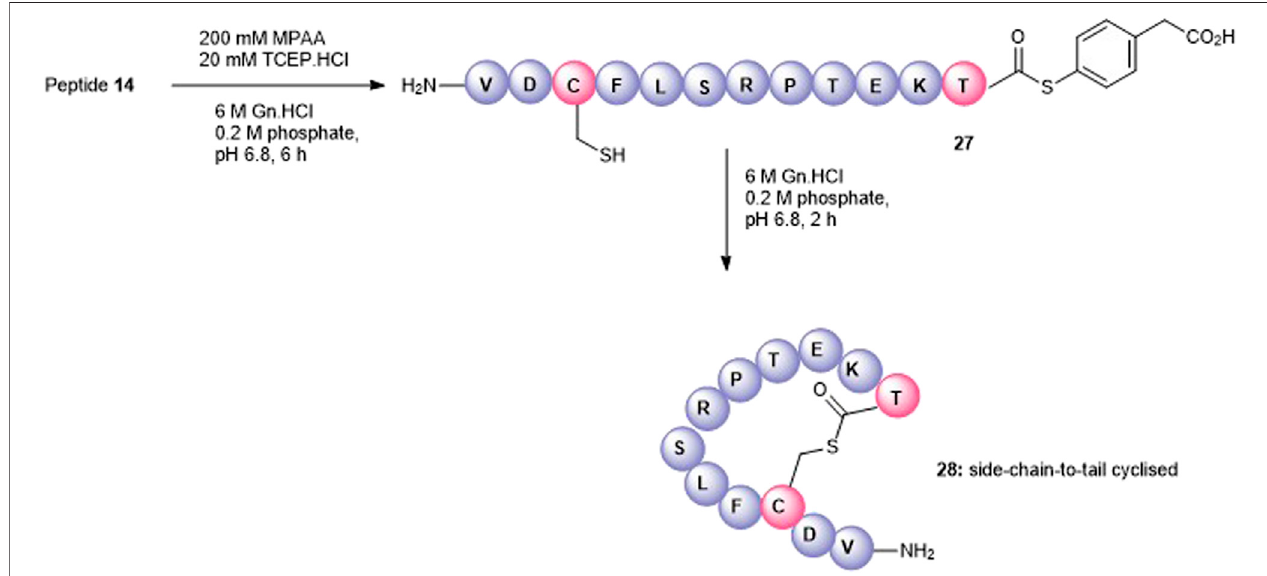
FIGURE 6 | Synthesis of the Cys3-Thr12 thioester-linked side-chain-to-tail cyclized peptide5 ( 28 ).